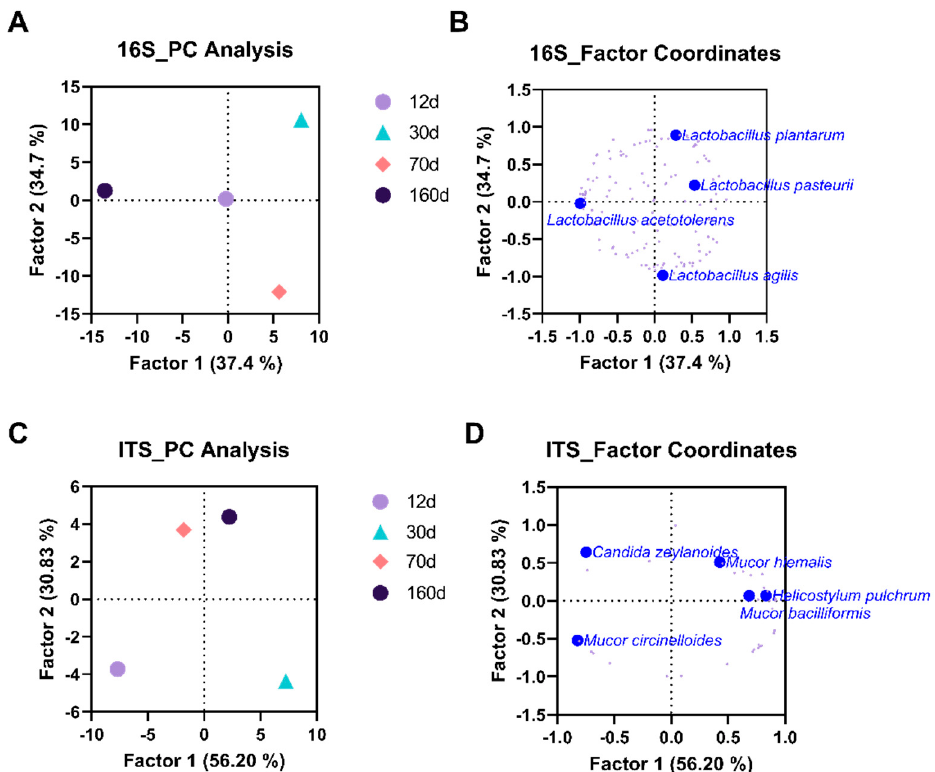
Figure 3. Plots of principal component and classification analysis based on cases ( A , C ) and variables ( B , D ). Taxonomy abundance counts of the microbial ( A , B ) and mycobial ( C , D ) communities on the surface of dry-aged beef with respect to the aging periods were projected into principal components based on the correlation matrix. Notable bacterial species on the factor coordinates are indicated ( B , D ). ● , day 12; ▲ , day 30; ♦ , day 70; and ● , day 160.